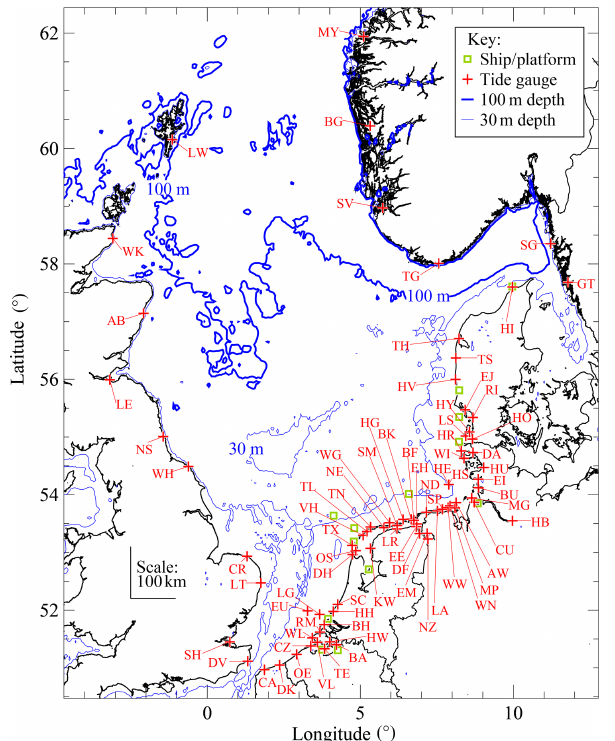
Figure 2. Location of tide gauges analysed in this study and of North Sea maritime incidents that were reported over the period 5–6 December 2013.